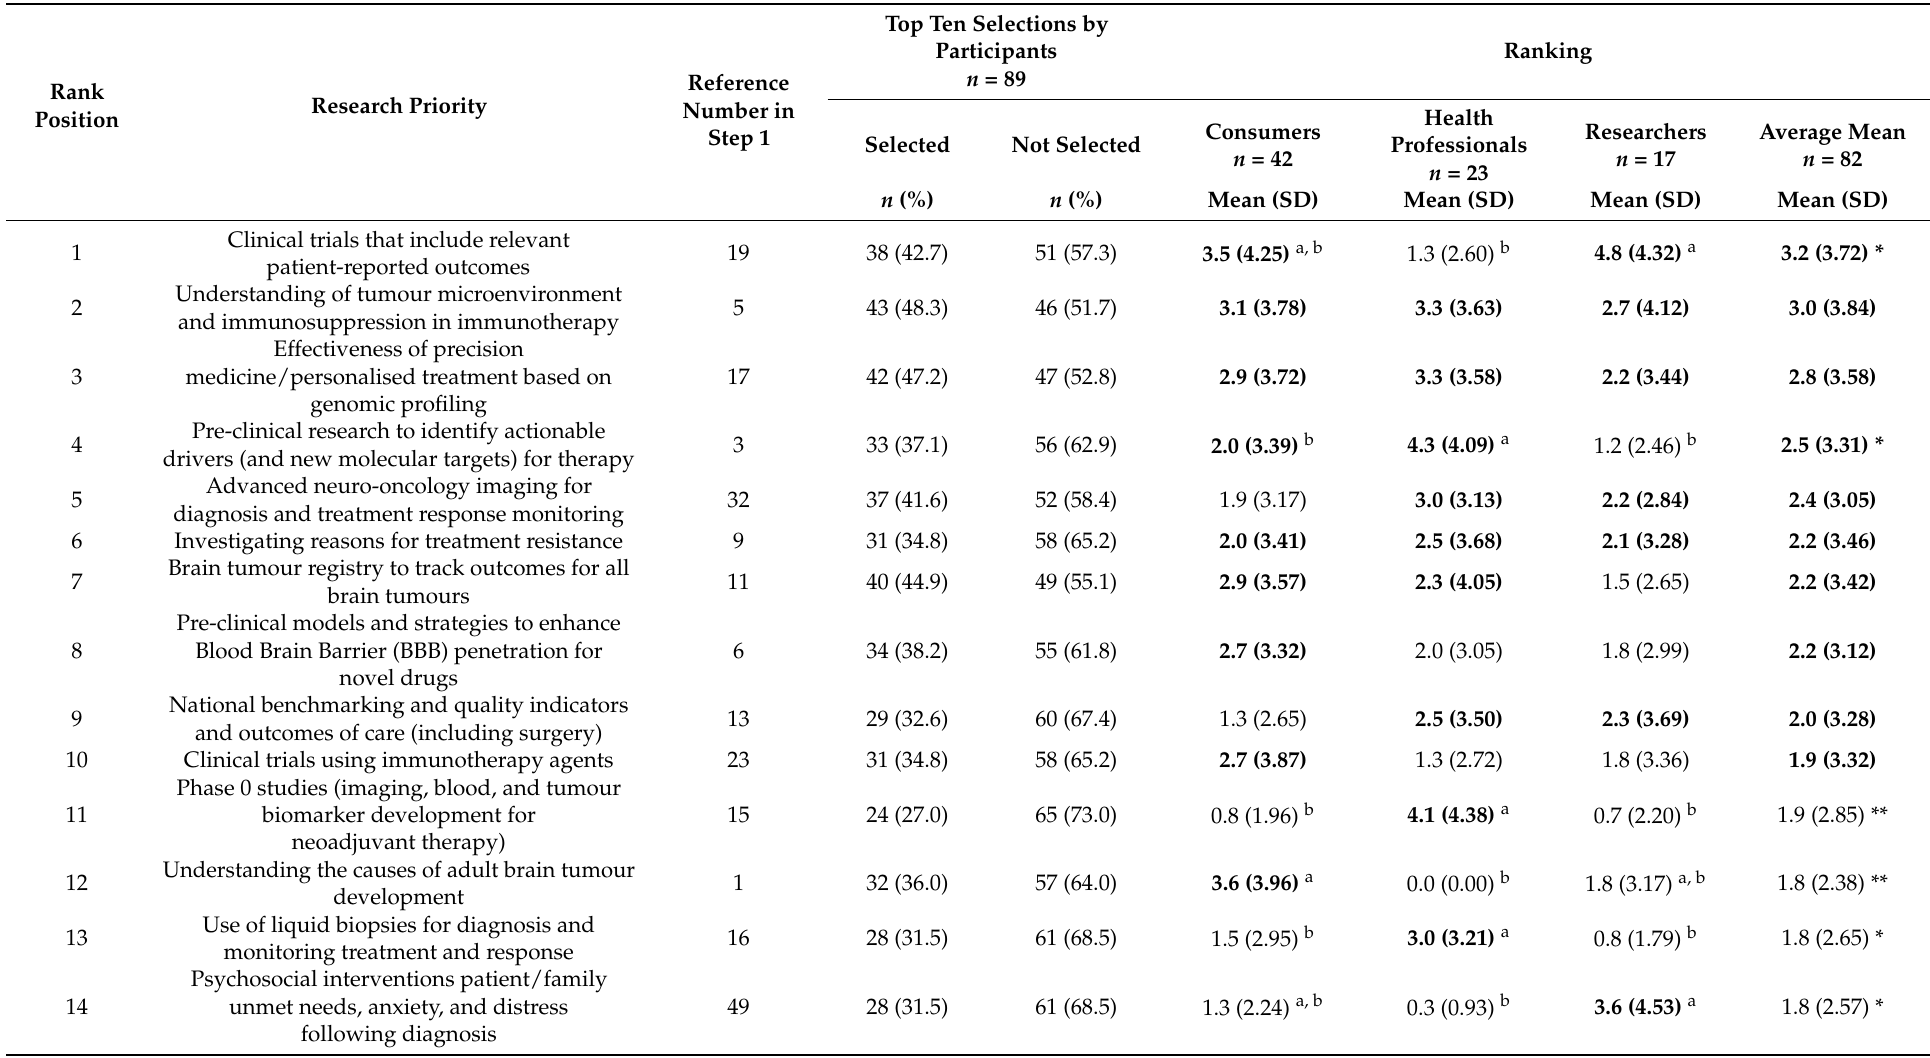
Table 5. Phase 2, Step 2—Participants’ selection of the top ten research priorities and adjusted mean rankings (higher mean equals higher